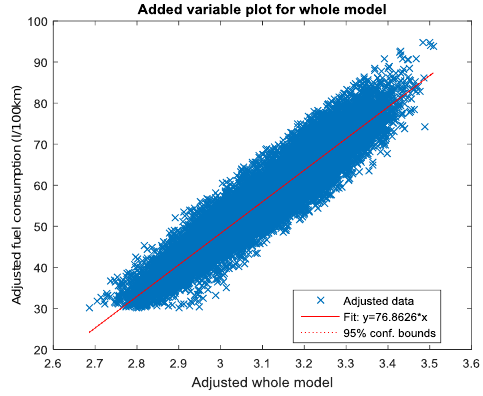
Figure 8. Effect of the whole model on fuel consumption.